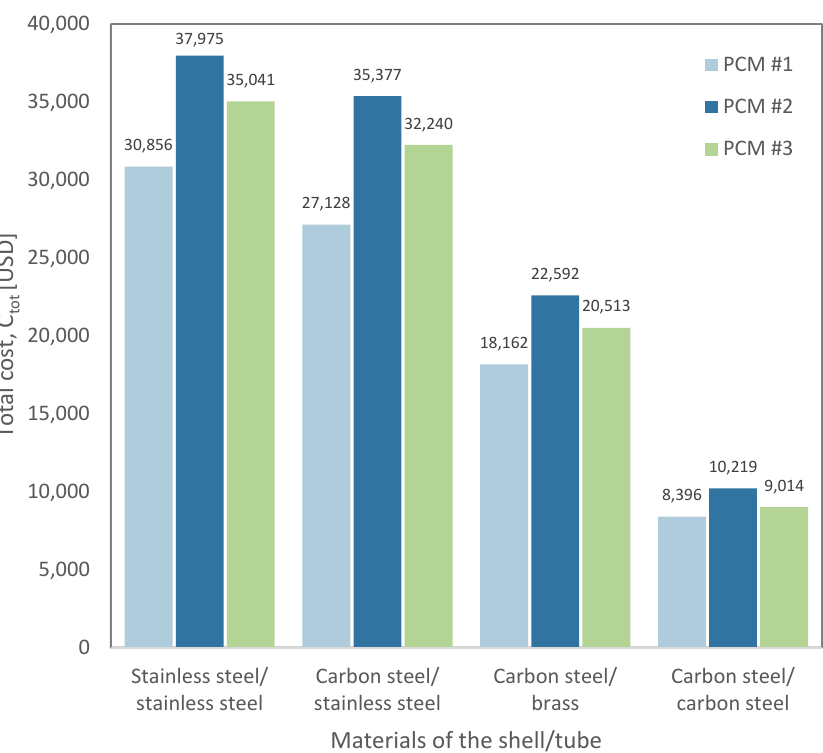
Figure 6. Comparison of the 1.42 kW LHTES unit using different shell and tube materials.